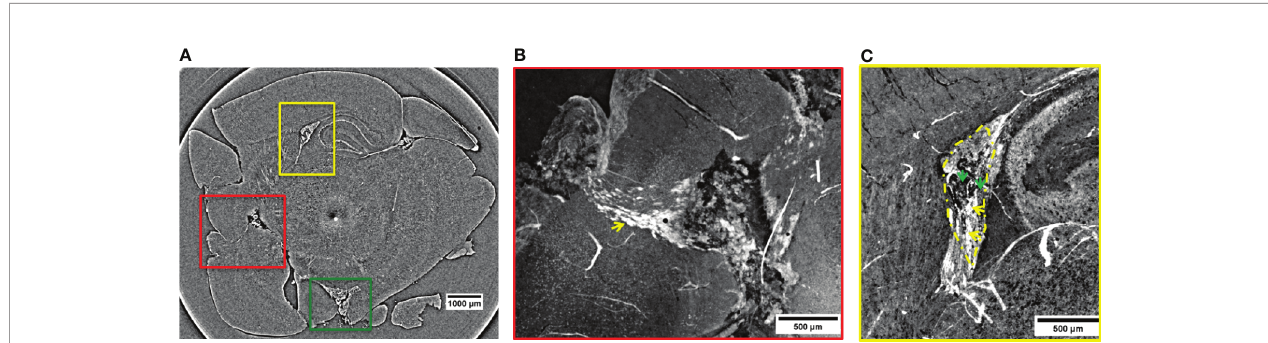
FIGURE 2 | 2D XPCT images showing metastases. (A) 2D XPCT slice with metastases highlighted within colored rectangles corresponding to (B, C) and 3. The dark dot accompanied by a white circle in the center of the slice is an artifact due to the rotation of the sample. (B) Volume rendered image of the region of interest indicated by the red rectangle in panel (A) . This tilted view shows a large tumor grown after the spreading of the injected tumor cells and, the pathway the NPs reached the tumor. The white small objects pointed out by the yellow arrow are identi fi ed as clusters of NPs, while the black dots are melanin pigments typical of melanomas. The image illustrates a complex repartition of NPs, with a major content localized at the edges with the healthy tissue, as indicated by the yellow arrow. (C) Volume rendering of the region of interest indicated by the yellow rectangle in panel (A) . The image shows a tumor developed in the lateral ventricle. Tumor contour is highlighted by the yellow dotted line. The yellow arrows indicate the tissue areas with a strong accumulation of NPs, while the green arrows point out areas poorer of NP